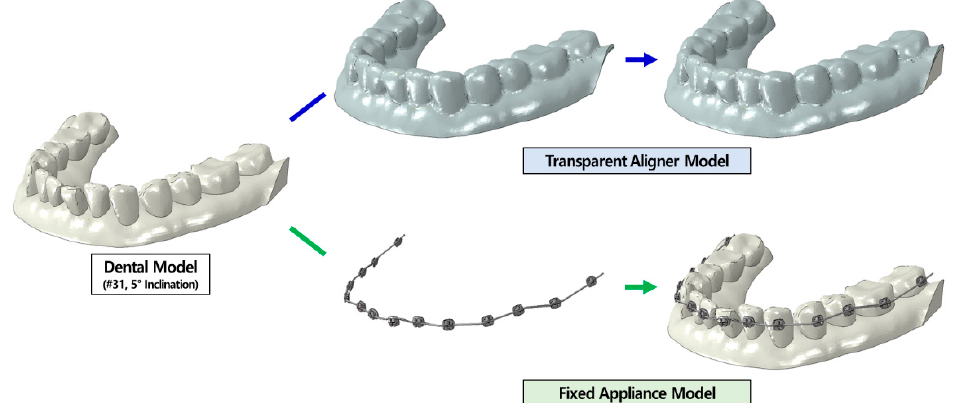
Figure 6. Reconstruction of the finite element models for verification of loading condition. ( left ) Cone-beam computed tomography data for normal tooth ‒ alveolar bone model was used to simulate all mandibular teeth and alveolar bone, and the #31 central incisor for force measurement was inclined at 5° to develop a verification model. ( center ) Development of transparent aligner and fixed appliance models using the same method as the orthodontic appliance model development method. ( right ) Transparent aligner and fixed appliance models were applied to the verification model to simulate the loading condition.